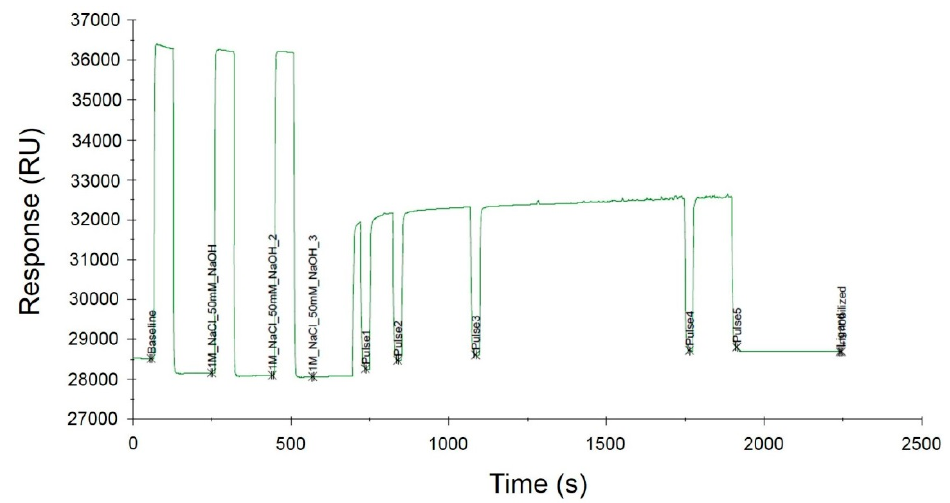
Figure 4. Immobilization of the biotinylated SA I/II SPR probe on the surface of the SA sensor